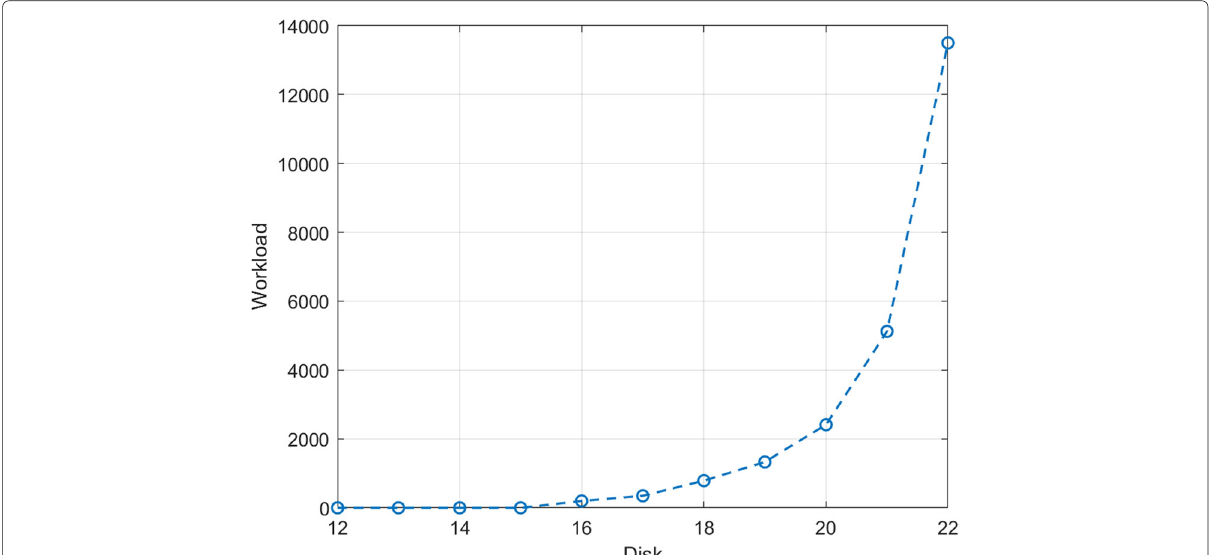
Fig. 4 The workload of the LG Nexus 5 according to the number of